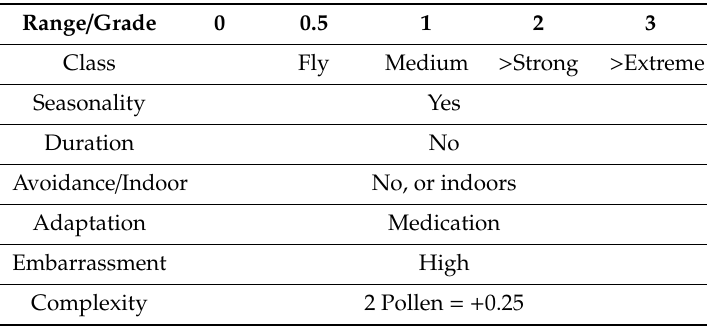
Table 4. Factors a ff ecting pollen.